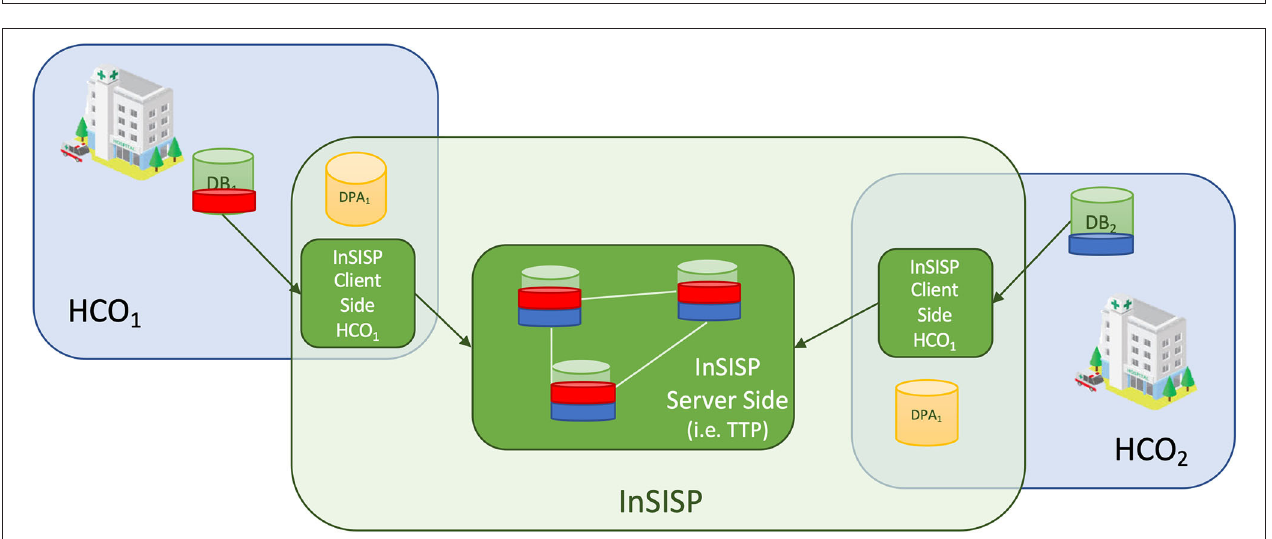
FIGURE 6 | Overview of the client/server design with a trusted third party